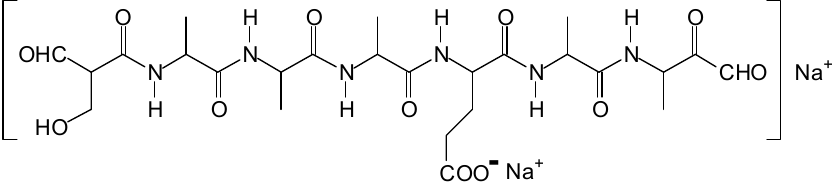
Figure 2. The MALDI ToF spectra of the soy protein isolate after a treatment with sodium periodate at 120 °C for 1 hour. ( a ) 100 Da to 500 Da range. ( b ) 500 Da to 1000 Da range. ( c ) 1000 Da to 1500 Da range.